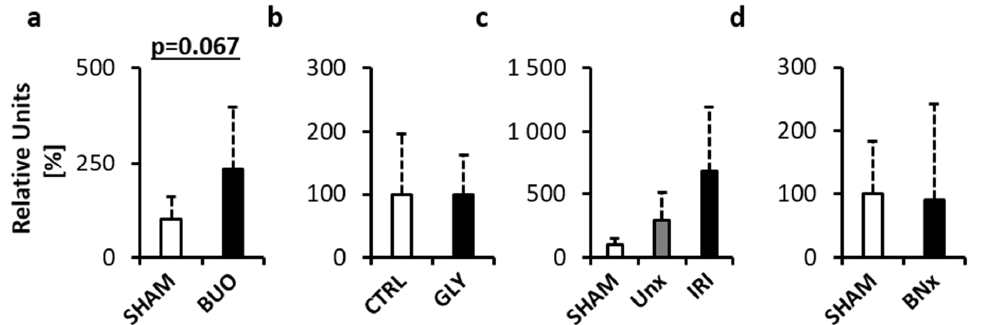
Figure 4. Mitochondrial ecDNA (mtDNA) measured in plasma of mice with acute kidney injury (AKI). ( a ) Bilateral ureteral obstruction. ( b ) Glycerol-induced AKI. ( c ) Ischemia–reperfusion injury. ( d ) Bilateral nephrectomy. Data are presented as mean + SD. BUO—bilateral ureteral ligation, GLY—glycerol-induced AKI, UNx—unilateral nephrectomy, IRI—ischemia–reperfusion injury, BNx—bilateral nephrectomy.